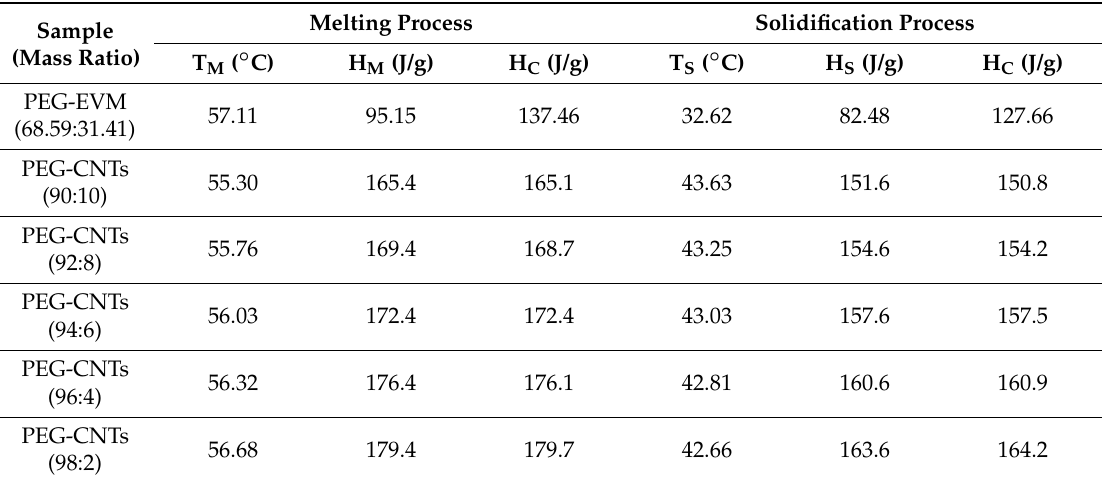
Table 4. Phase change temperature, measured and calculated latent heat of PCE-CPCMs without CNTs (PEG-EVM) and without EVM (PEG-CNTs) during the melting and solidification processes [13,23] a